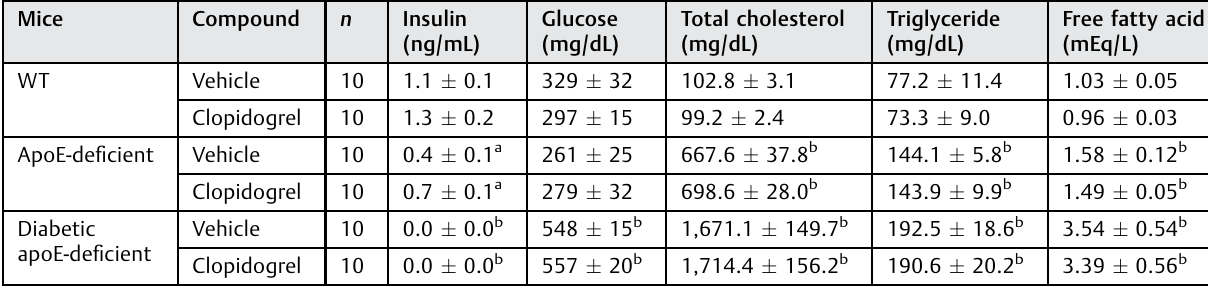
Table 1 Effects of clopidogrel on blood physiological parameters in wild-type, apoE-de fi cient, and diabetic apoE-de fi cient mice